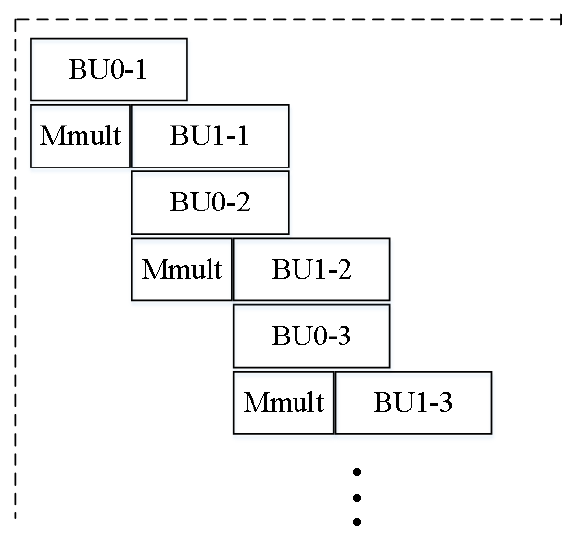
Figure 9. Pre/postprocessing operation flow of NTT